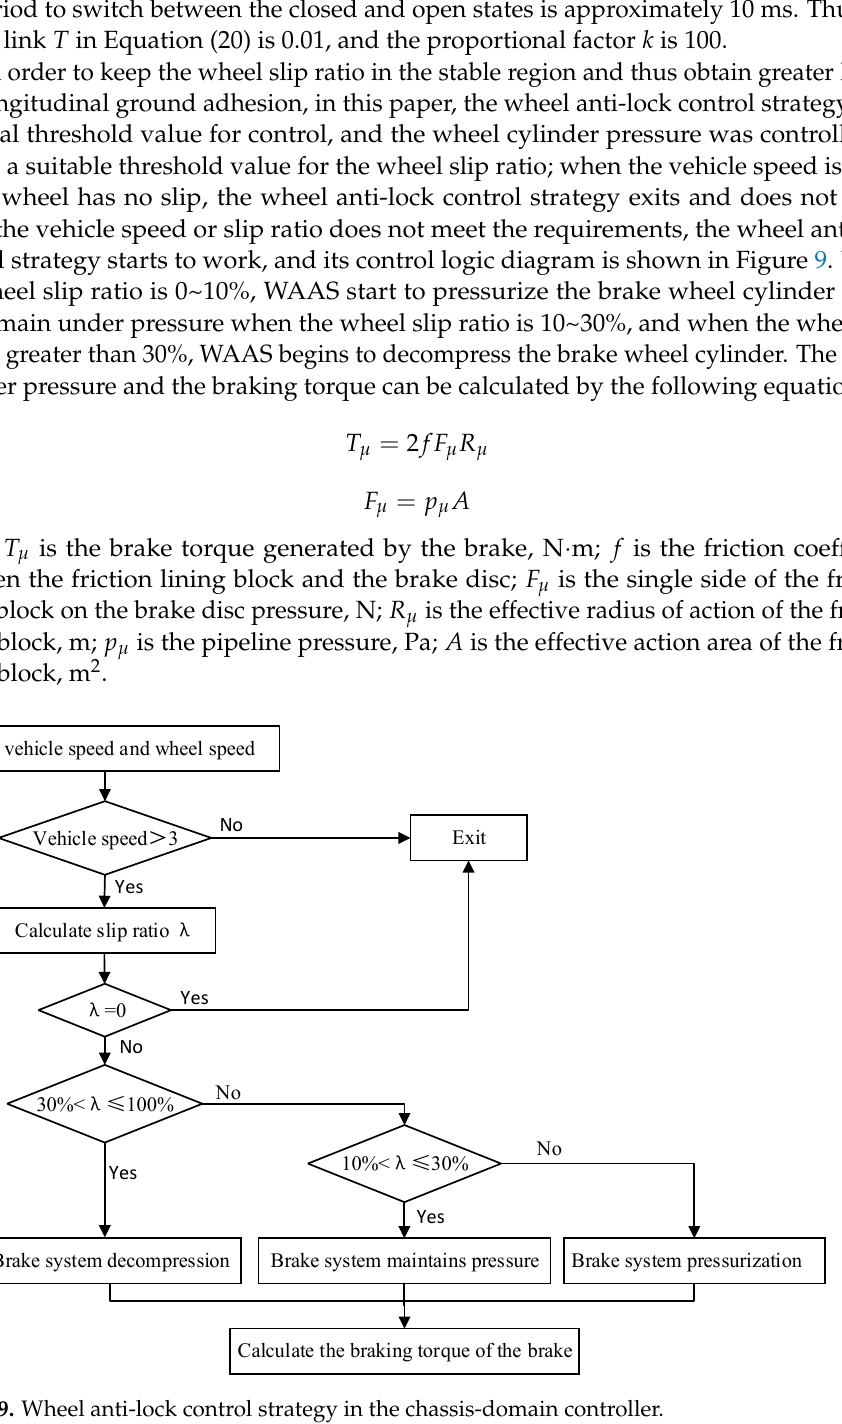
Figure 9. Wheel anti-lock control strategy in the chassis-domain controller.